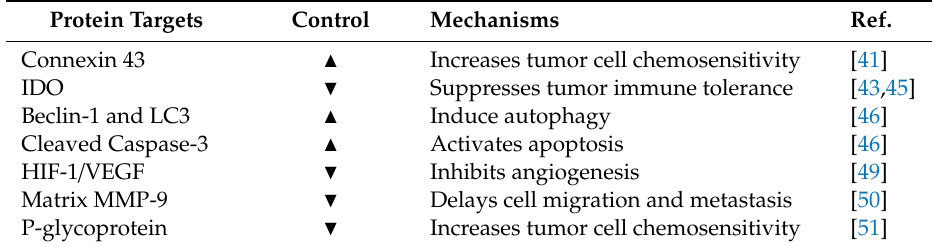
Table 1. A summary of the tumor cell signaling targets of Salmonella -mediated tumor